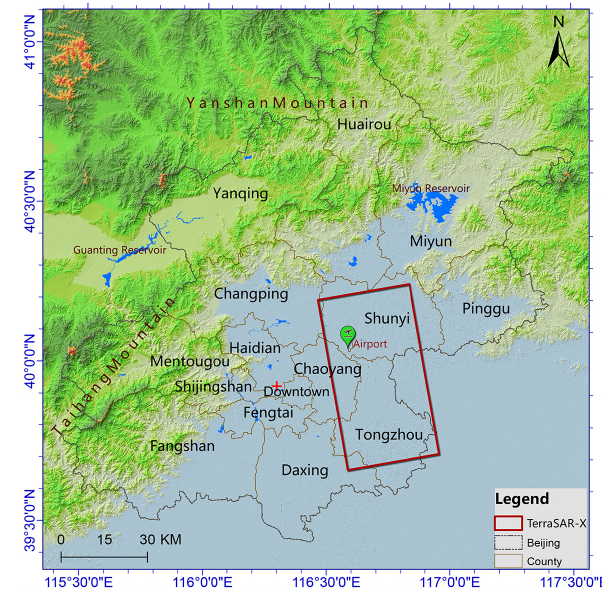
Figure 1. Map of the study area, Beijing Plain, China. The red box in the figure represents the coverage of the TerraSAR-X stripmap which covers an area of more than 1900km 2 . The blue polygons are water bodies. The red cross symbol represents the location of the referenced M1 benchmark.